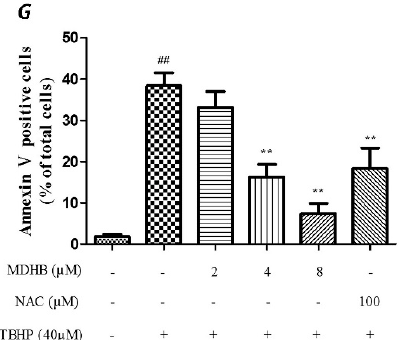
Figure 2. Effect of MDHB on TBHP-induced apoptosis in SH-SY5Y cells. ( A ) Control group; ( B ) 40 μ M THBP group; ( C ) 2 μ M MDHB + TBHP group; ( D ) 4 μ M MDHB + TBHP group; ( E ) 8 μ M MDHB + TBHP